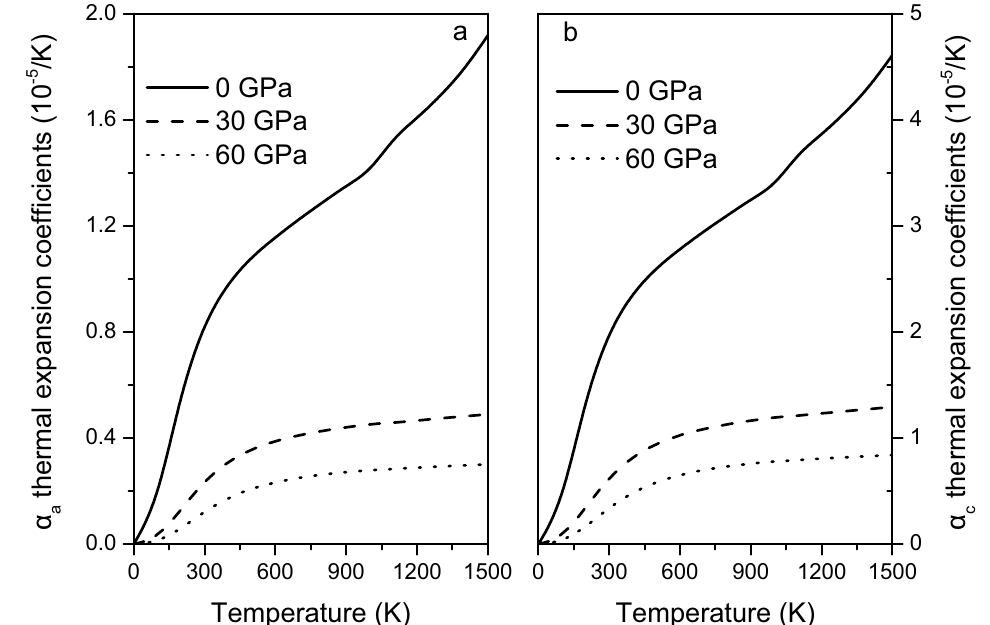
Figure 14. Linear thermal expansion coefficients α a ( a ) and α c ( b ) along the [100] = [010] and [001] directions of magnesite at various